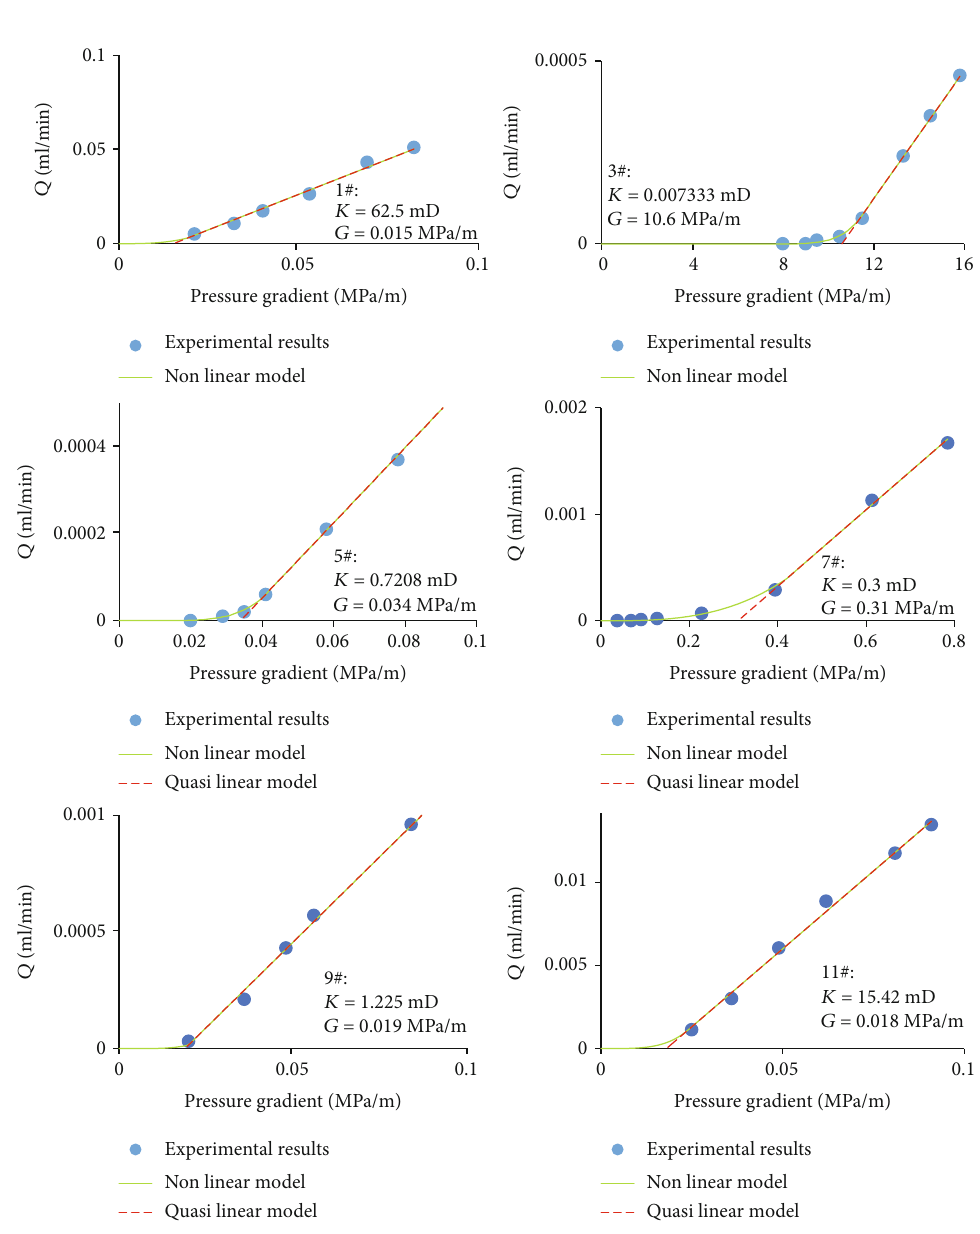
Figure 5: Permeability variation and fi tting of core during step-up and down-pressure